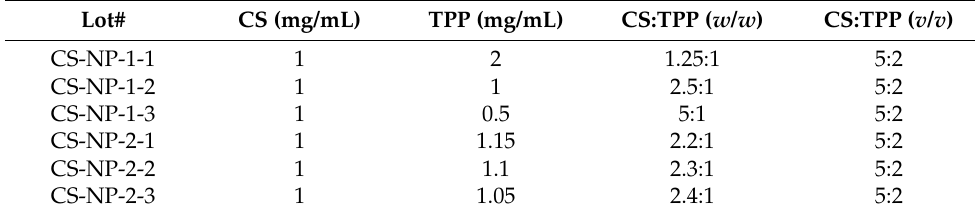
Table 4. Preparation conditions of chitosan nanoparticles (CS-NPs) samples.